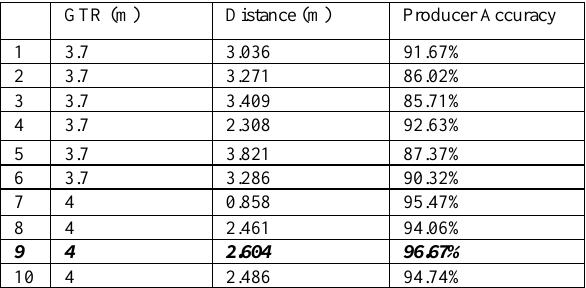
Table 2. Ground Truth Resolution (GTR), Distance between centres of extracted polygon and hole, Production accuracy and